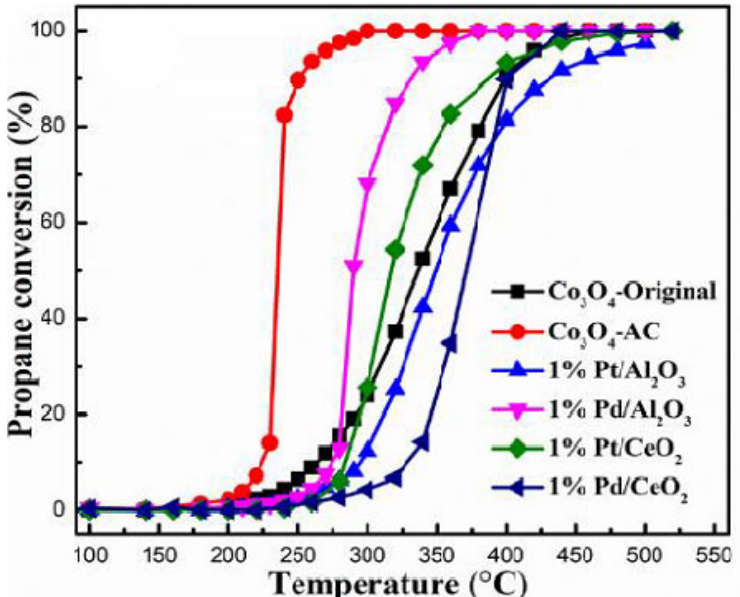
Figure 1. Catalytic combustion of propane (0.3% C 3 H 8 , 10% O 2 , and N 2 balanced) as a function of temperature over Co 3 O 4 , commercial 1%Pt/Al 2 O 3 and 1%Pd/Al 2 O 3 , and self-made 1%Pt/CeO 2 and 1%Pd/CeO 2 , at WHSV of 240000 mL g − 1 h − 1 . Reprinted and adapted with permission from Ref. [41].